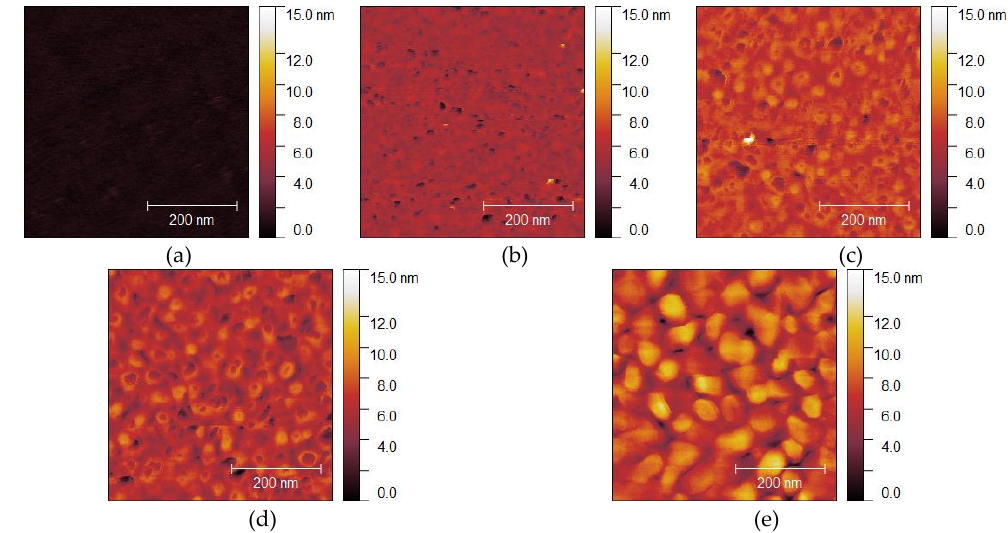
Figure 9. Typical AFM images of Au thin films deposited on Si wafers with cavities: ( a ) before deposition; ( b )–( e ) after deposition of films with thicknesses of 15, 50, 100, and 300 nm, respectively.